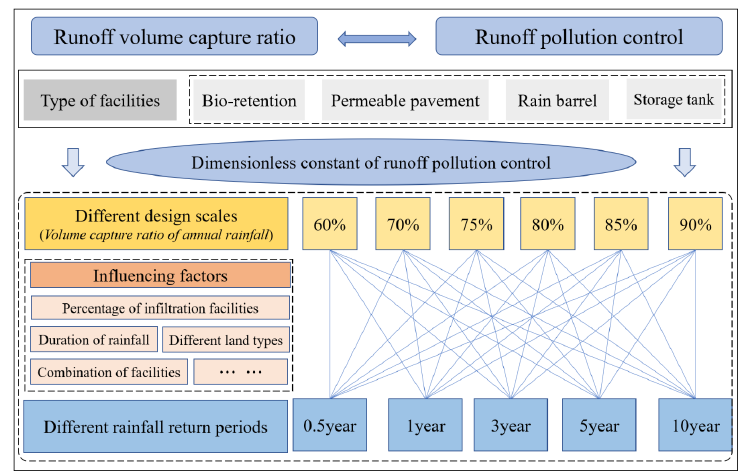
Figure 1. The methodological framework of the present